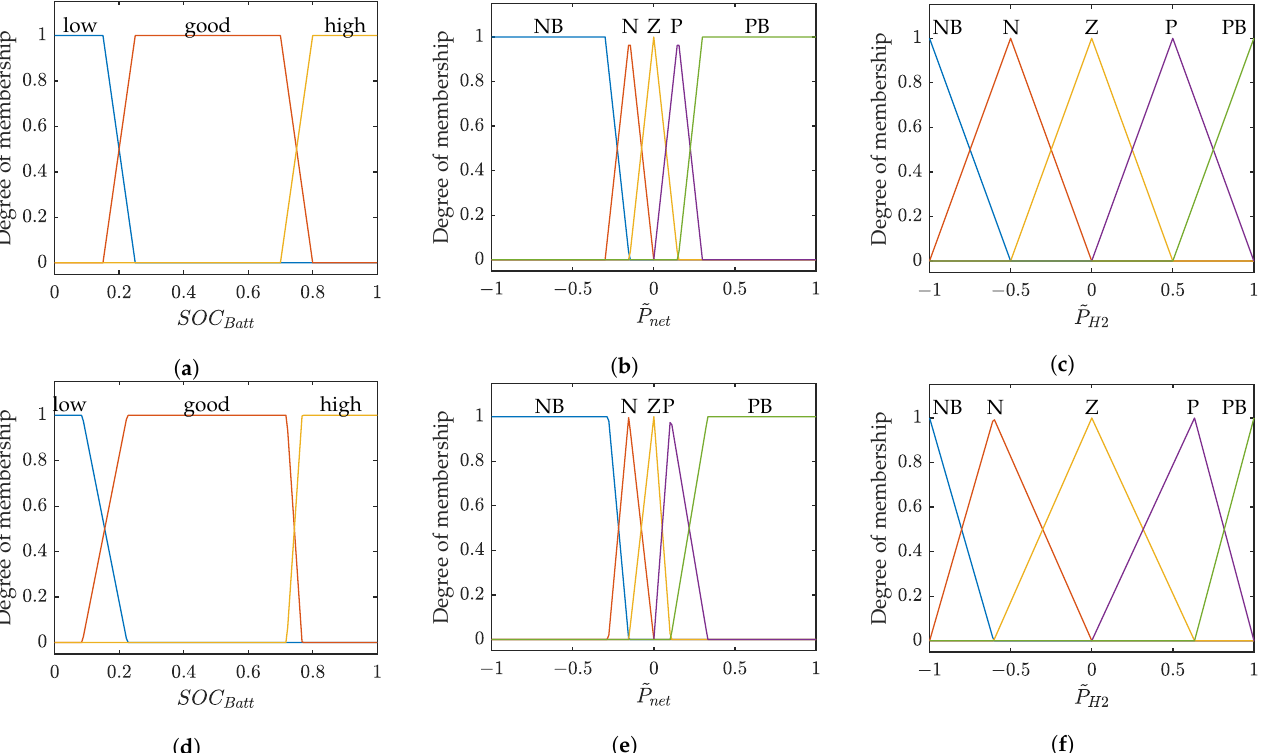
Figure 15. Membership functions: expert tuned ( a – c ) and optimized ( d – f ). ( a , d ) Input 1: battery SOC. ( b , e ) Input 2: Net Power ˜ P net . ( c , f ) Output: electrolyzer/fuel cell power ˜ P H 2